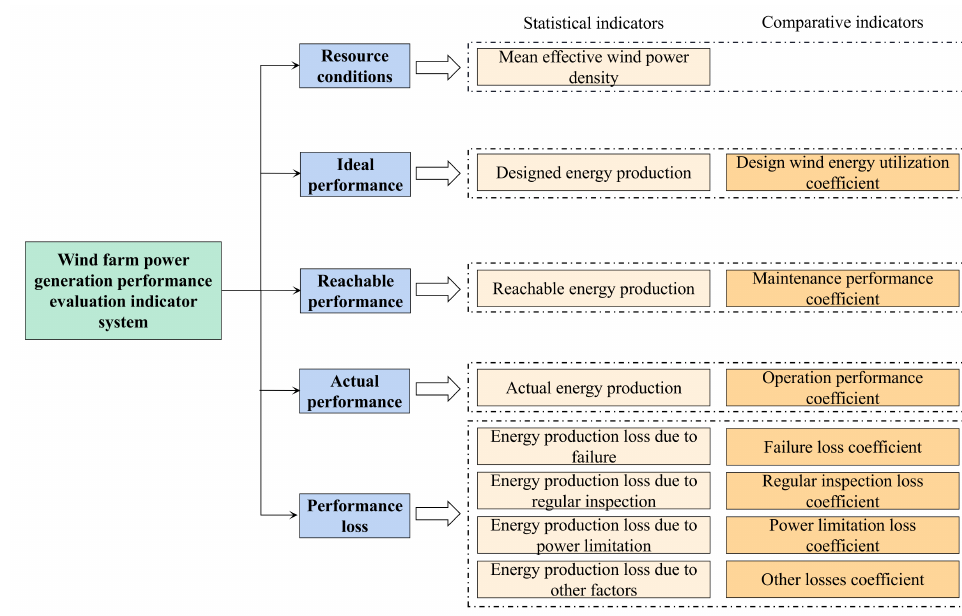
Figure 1. Wind farm power generation performance evaluation indicator